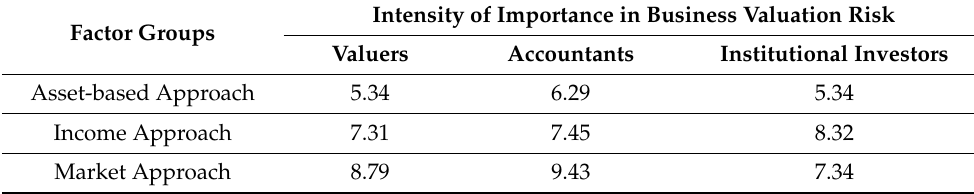
Table 4. Assessment of Case Studies’ Values Based on Group